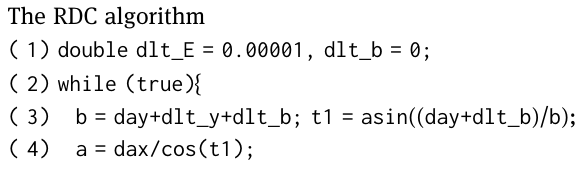
ellipse arc e B , and the segment P P Fi fi is perpendicular to 0 ) . the arc e B 1